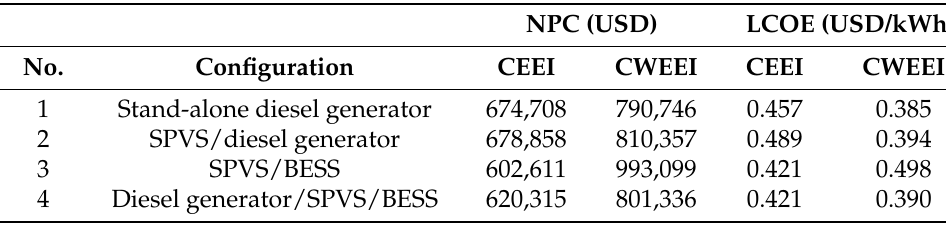
Table 8. Costs of the configurations under study over the planning